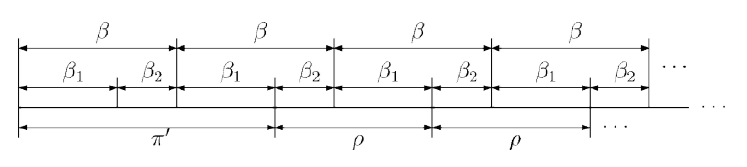
Fig. 5: Structure of τ 2 in case | τ 2 | > max {| β 2 | , | π (cid:48) ρ 2